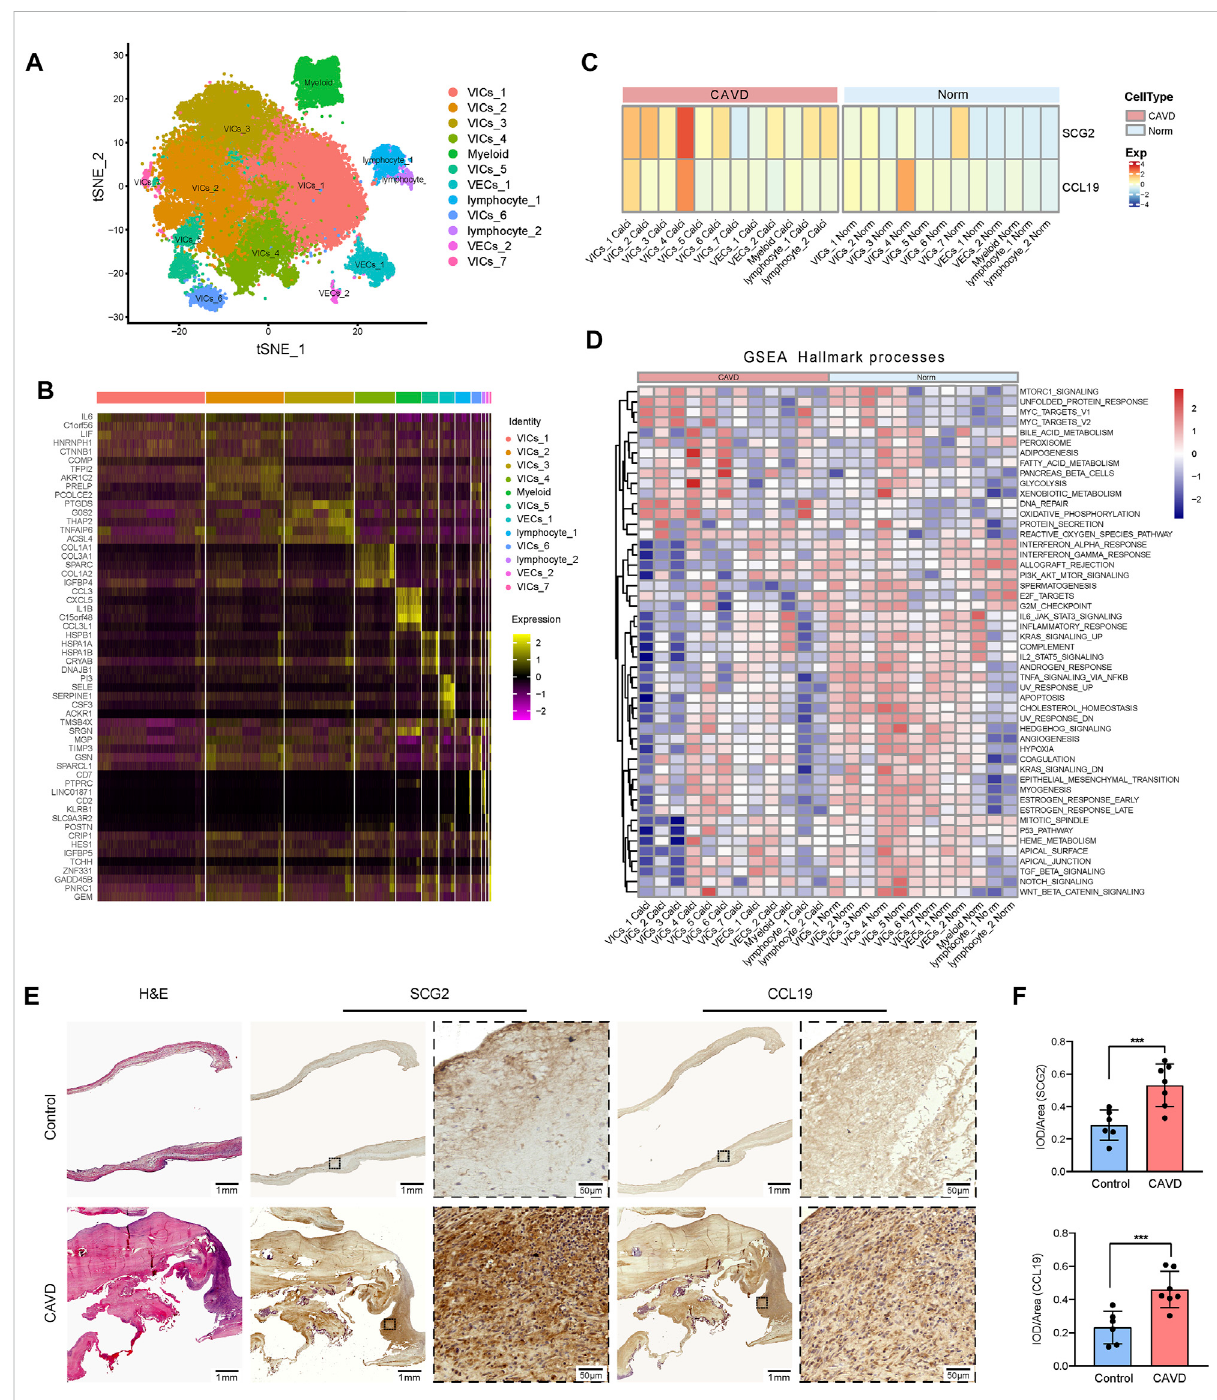
FIGURE 8 Validation at single cell level and tissue level. (A) tSNE visualization of clustering revealed 12 cell populations. Cell population identities were determined based on marker gene expression. (B) Heatmap of top 5 marker genes for each cell cluster. (C) Heatmap shows the expression of SCG2 and CCL19 in 12 clusters of cells in CAVD group and normal control group, respectively. The transition from blue to orange represents the increasedexpressionlevel. (D) TheheatmapofGSEAanalysisresultsshowsthehallmarkfunctionalpathwaysenrichedineachofthecalci fi edor normal aortic valve cell clusters. The transition from blue to red indicates the increased enrichment of pathways. (E) H and E staining and immunohistochemical staining of human aortic valve tissue sections. Macroscopic and micrographs views of immunohistochemical staining of SCG2 and CCL19 from left to right. (F) Histograms of quantitative immunohistochemical staining results. The expression of SCG2 and CCL19 was signi fi cantly increased in CAVD group. AUC: Area under the ROC curve; 95% CI: 95% con fi dence interval; Norm: normal; CAVD: calci fi c aortic valve disease; VICs: valvular interstitial cells; VECs: valvular endothelial cell; TCs: T cells. *** p <